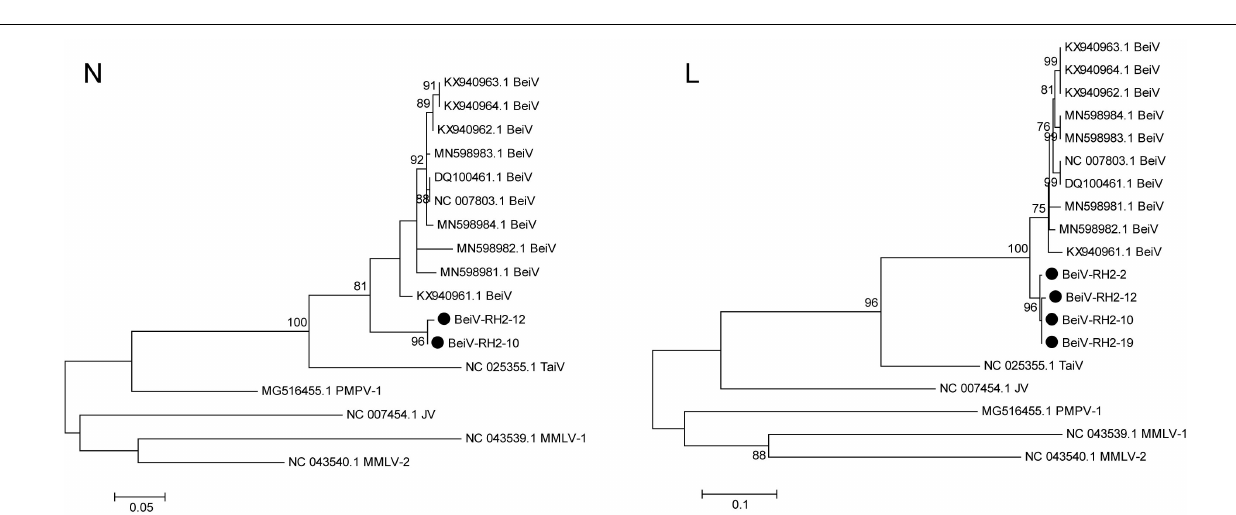
FIGURE 6 | Maximum likelihood phylogenetic tree constructed based on the N and L segments of Beilong virus. Beilong Jeilongvirus (Beilong virus, BeiV), Tailam Jeilongvirus (Tailam virus, TaiV), Lophuromys Jeilongvirus 1 (Mount Mabu Lophuromys virus 1, MMLV-1), Lophuromys Jeilongvirus 2 (Mount Mabu Lophuromys virus 2, MMLV-2), Mydes Jeilongvirus (Pohorje Myodes paramyxovirus 1, PMPV-1), and Jun Jeilongvirus (J-virus,